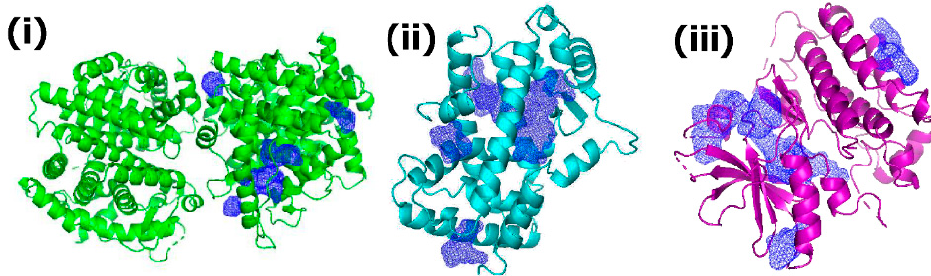
Figure 1. Binding pocket analysis based on POCASA results ( i ) ER α ; ( ii ) PPAR- α ; ( iii ) EGFR. Shaded blue regions indicate binding pockets.